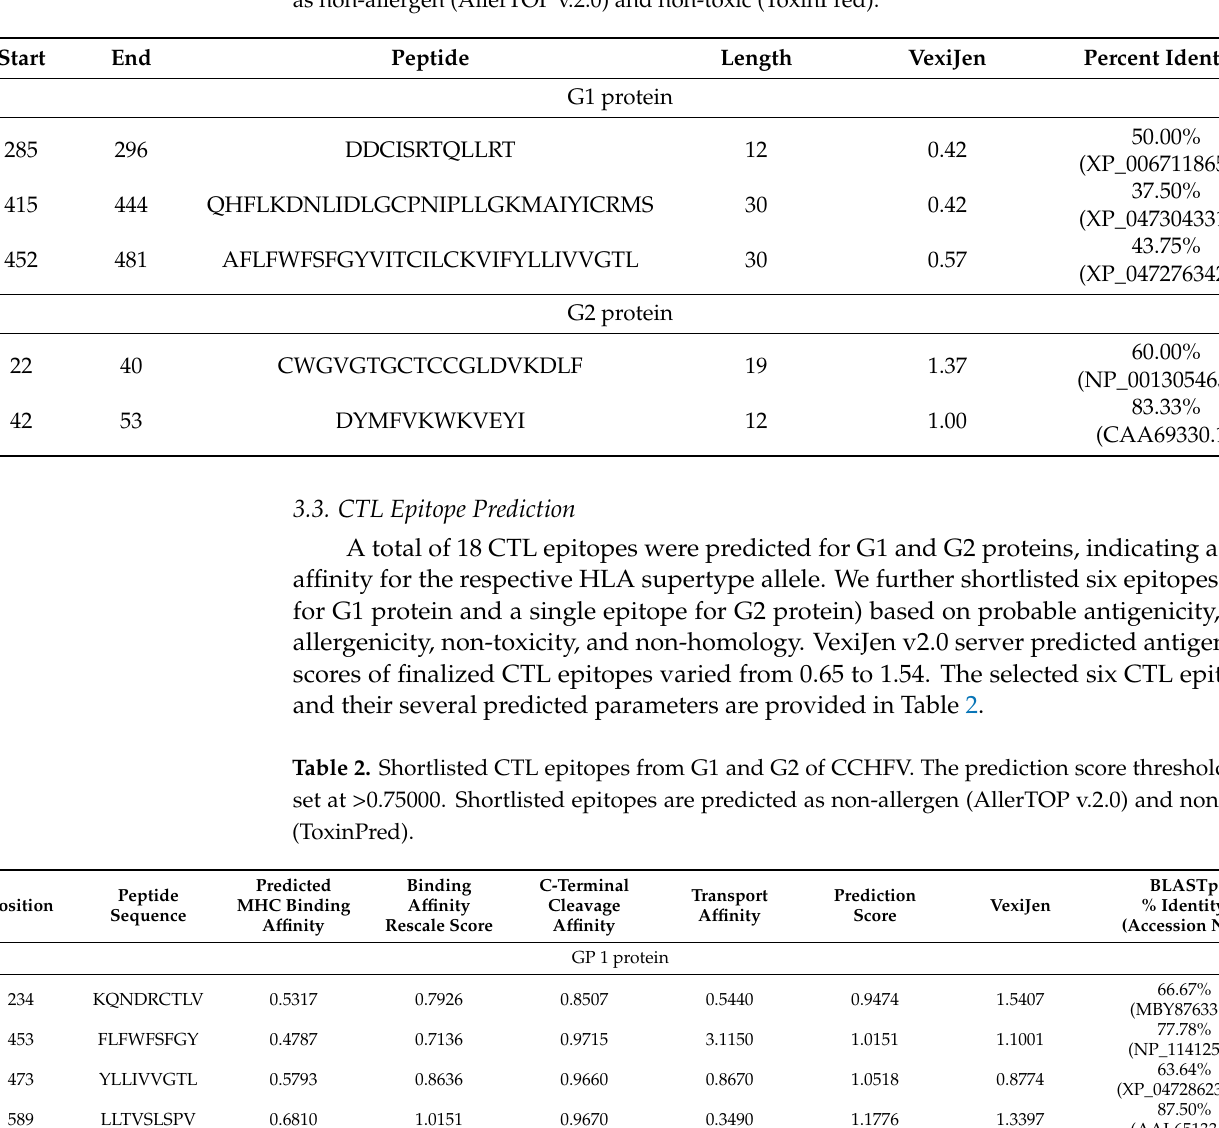
Table 1. Shortlisted linear B-Cell Epitopes from G1 and G2 of CCHFV. These epitopes are predicted as non-allergen (AllerTOP v.2.0) and non-toxic (ToxinPred).